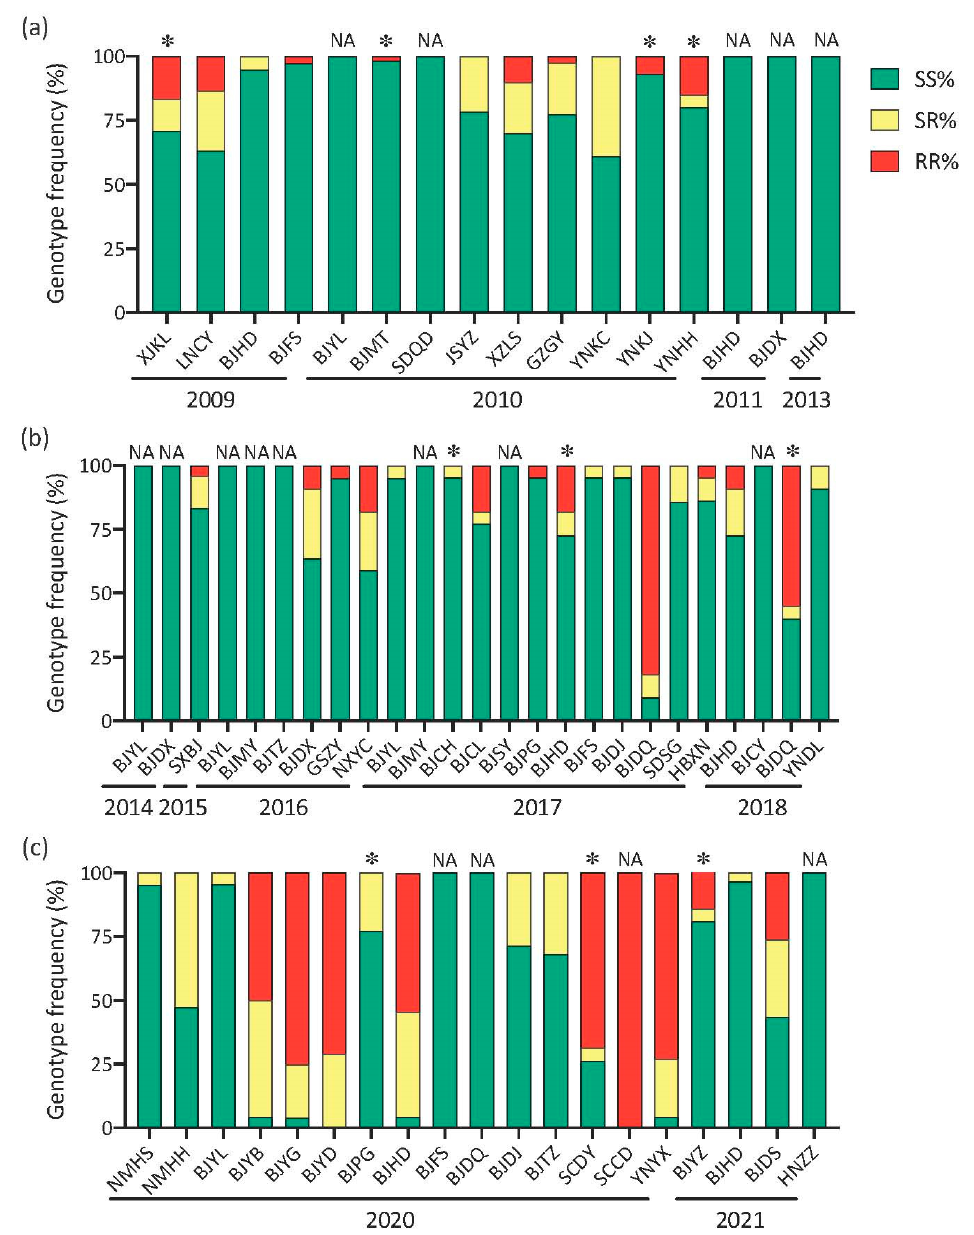
Figure 2. Genotype frequencies of G275E mutation in Frankliniella occidentalis populations during ( a ) 2009–2013, ( b ) 2014–2018 and ( c ) 2020–2021. RR, resistant homozygote genotype; RS, heterozygote genotype; SS, sensitive homozygote genotype. The “*” represents deviations from Hardy-Weinberg equilibrium ( p < 0.05); NA represents a population consisting only of homozygous genotypes.